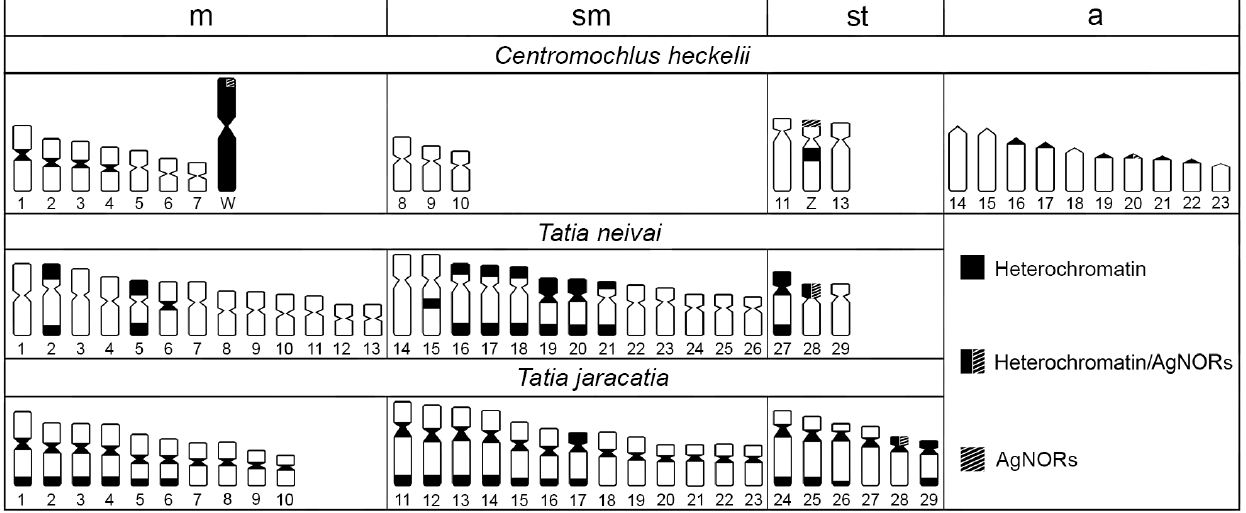
FIGURE 2 | Idiograms representing the karyotype and locations of heterochromatin and AgNORs in Centromochlus heckelii (present study) in comparison to Tatia neivai and Tatia jaracatia (Lui et al ., 2013a). m : metacentric chromosomes; sm : submetacentric chromosomes; st : subtelocentric chromosomes; a : acrocentric